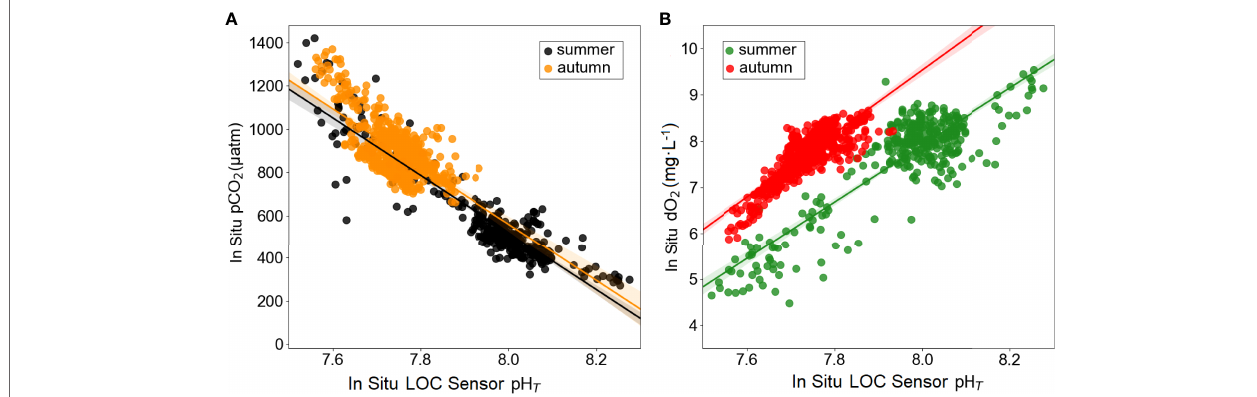
FIGURE 7 | Linear regression (solid lines) plots between (A) pCO 2 and pH T (black circles present the data from the summer time-series in situ data presented in Figure 4 , linear fit yielded r 2 = 0.85 (n=346) and orange circles present the data from the autumn time-series in situ data presented in Figure 5 , linear fit yielded r 2 = 0.46 (n=632), and (B) dO 2 and pH T (green circles present the data from the summer time-series in situ data presented in Figure 4 , linear fit yielded r 2 = 0.77 (n=346) and red circles present the data from the autumn time-series in situ data presented in Figure 5 , linear fit yielded r 2 = 0.70 (n=632).